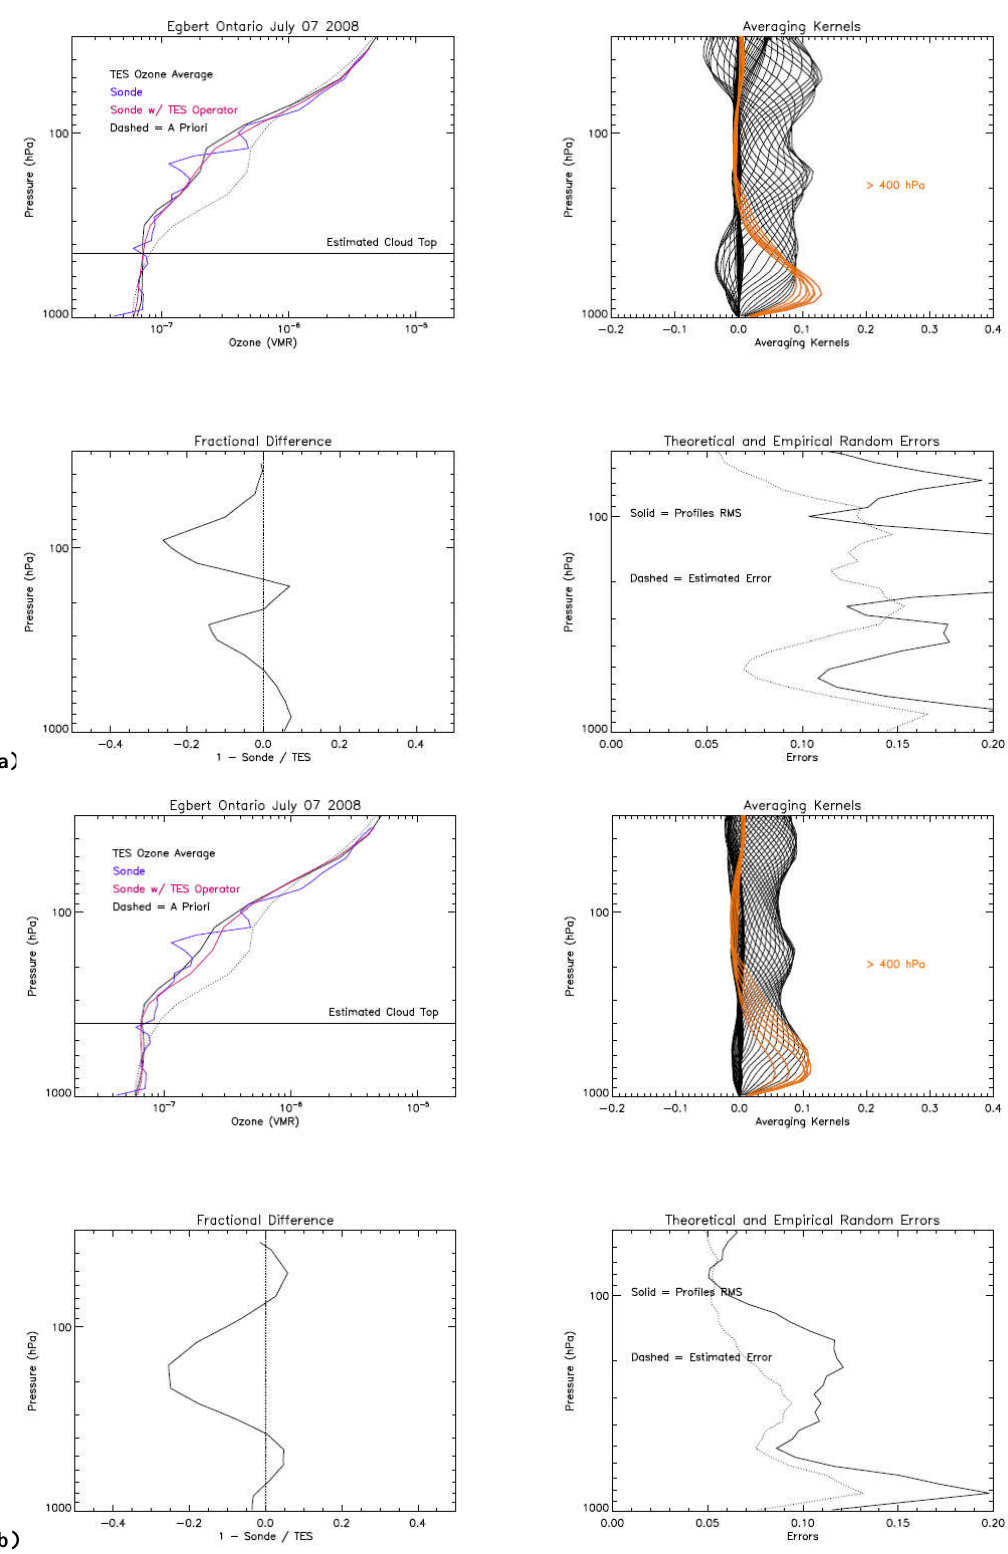
Fig. 4. The TES-stare sequence on 5 July 2008 over Egbert started at 17:58 (UTC), and the ozonesonde on that day at Egbert was launched at 18:25 (UTC), using V003 (a) and V004 (b) TES